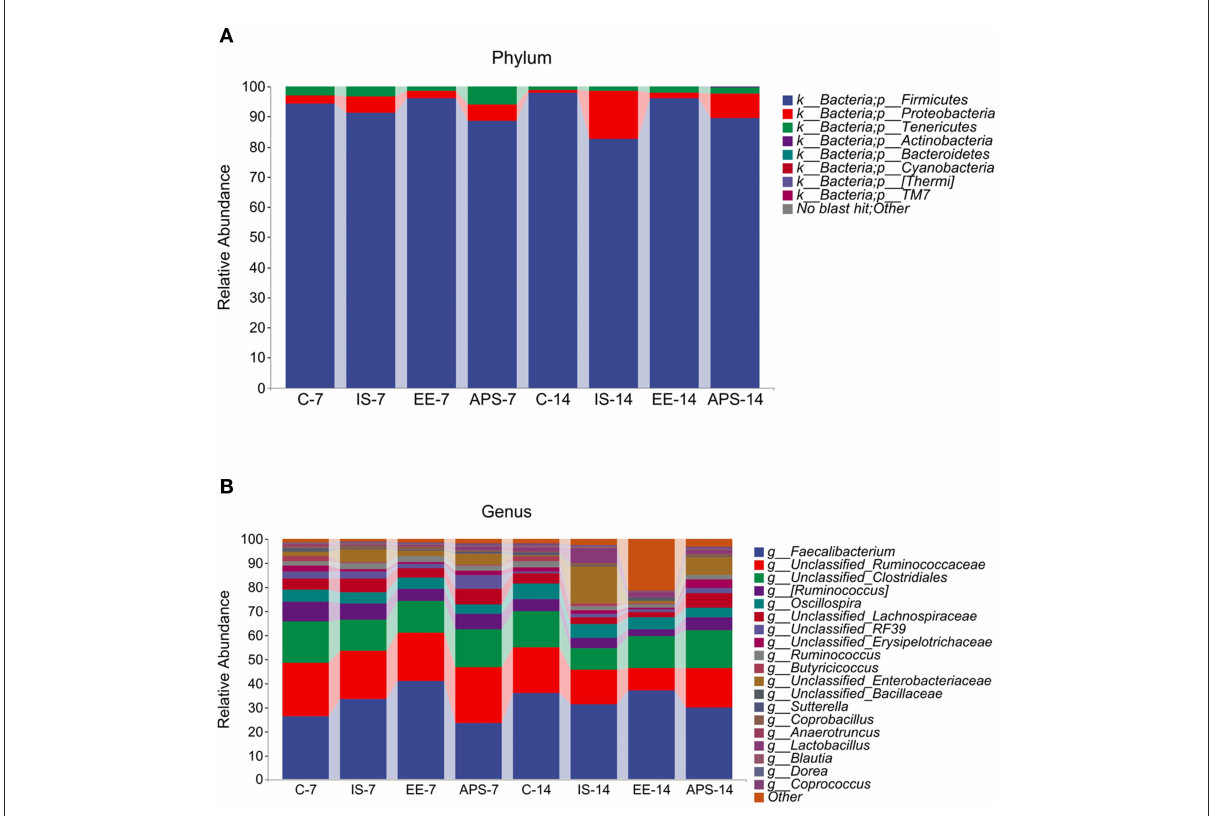
FIGURE2 Map of taxonomic composition and abundance distribution of communities at the phylum and genus level. (A) Phylum; (B) Genus. The horizontal coordinates are arranged according to groups at different times with each bar representing a group and colors distinguishing each taxonomic unit. The vertical coordinates represent the relative abundance of each taxonomic unit. The longer the bar, the higher the relative abundance of that taxonomic unit in the corresponding sample ( N =